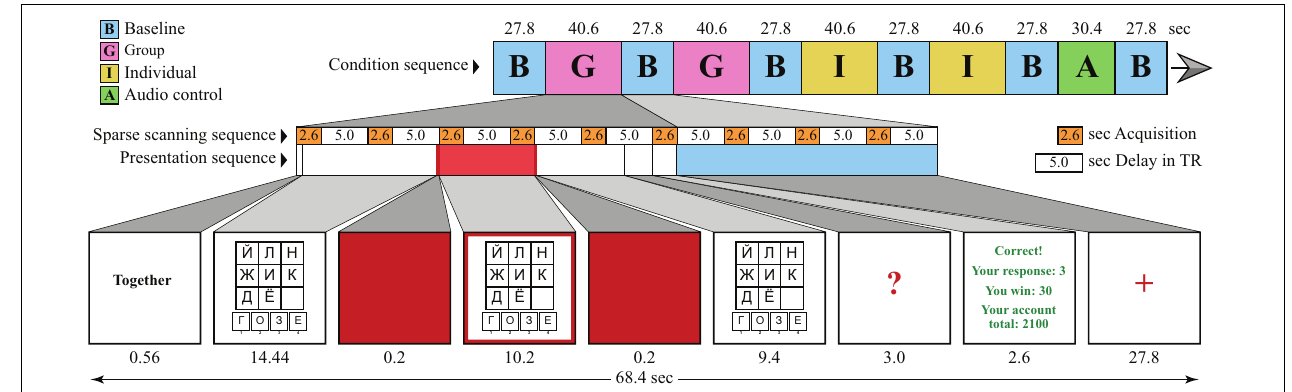
FIGURE 2 | Timeline of the stimuli. Each trial started with instruction indicating whether the subsequent problem should be solved collectively or individually. The subsequent problem solving is split into three time periods: before, during, and after the presentation of the red frame at the edge of the screen. Player 1 is required to keep silent during the red frame period and to speak up during the two other periods. All participants are required to keep silent during the fixation baseline (red cross). Sparse acquisition of the functional MR volumes is illustrated by the white and orange bars.